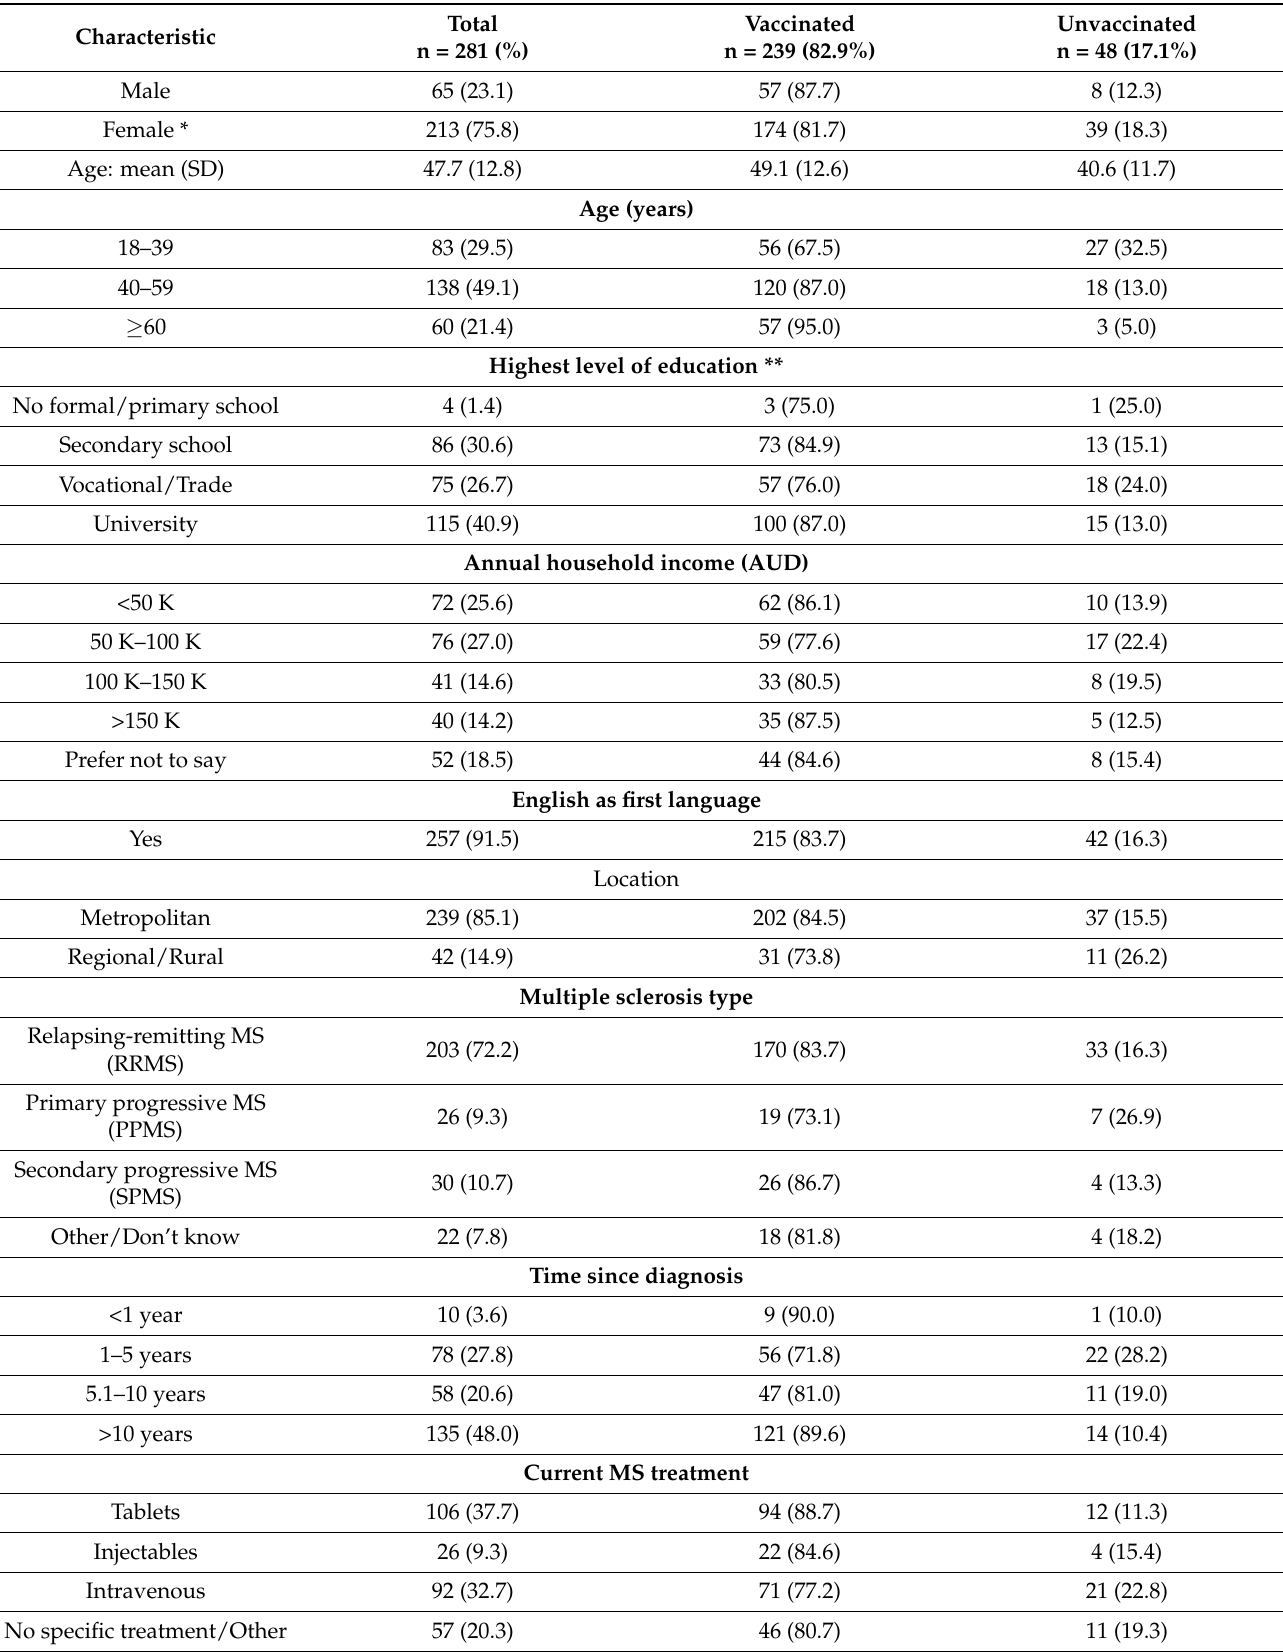
Table 1. Participant